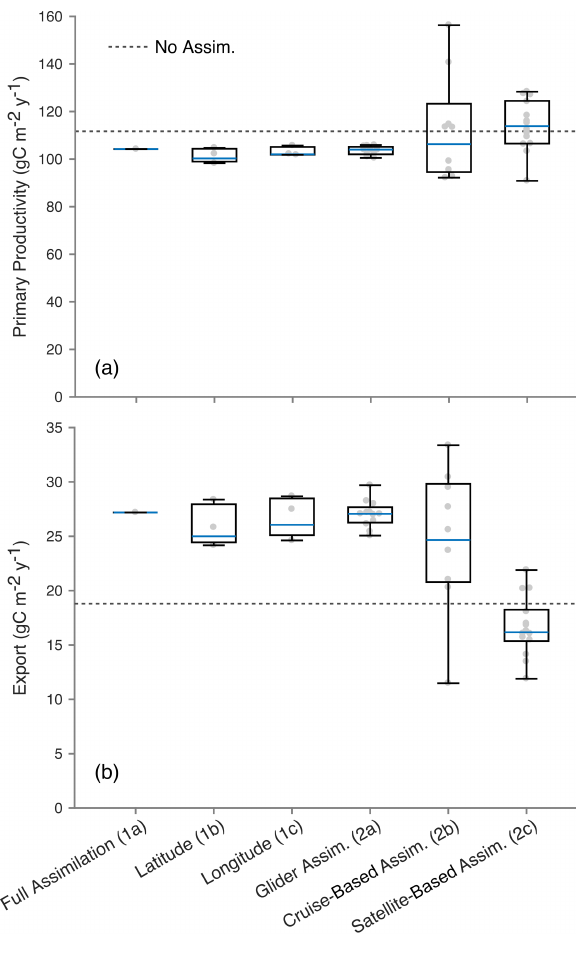
Figure 7. Distributions of (a) depth- and time-integrated production and (b) carbon export flux at 200m for each assimilation experi- ment (Table 2). The median value for each experiment is indicated by a horizontal light-blue line. Each box extends vertically from the first to third quartile, and the whiskers extend from the lowest to highest values. Individual values are shown as gray dots. For ref- erence, production and export estimates from the No Assimilation (dashed gray line) case is included in each